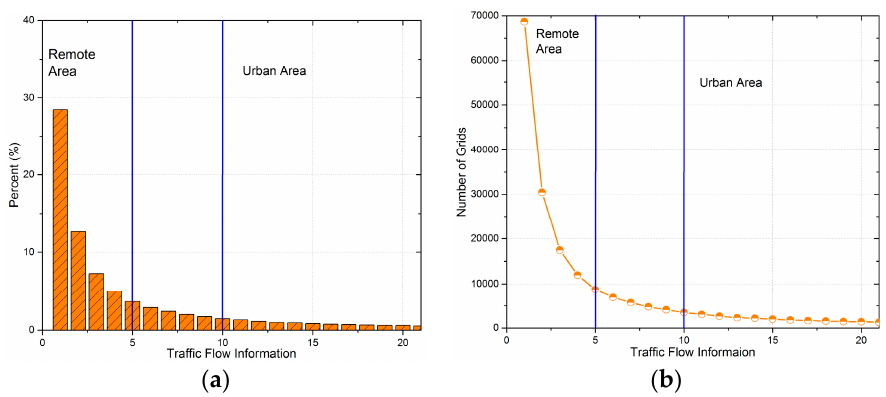
Figure 5. Summary statistics of the T-Drive dataset. ( a ) Percent of grids with different traffic flow information; ( b ) Number of grids with different traffic flow information.